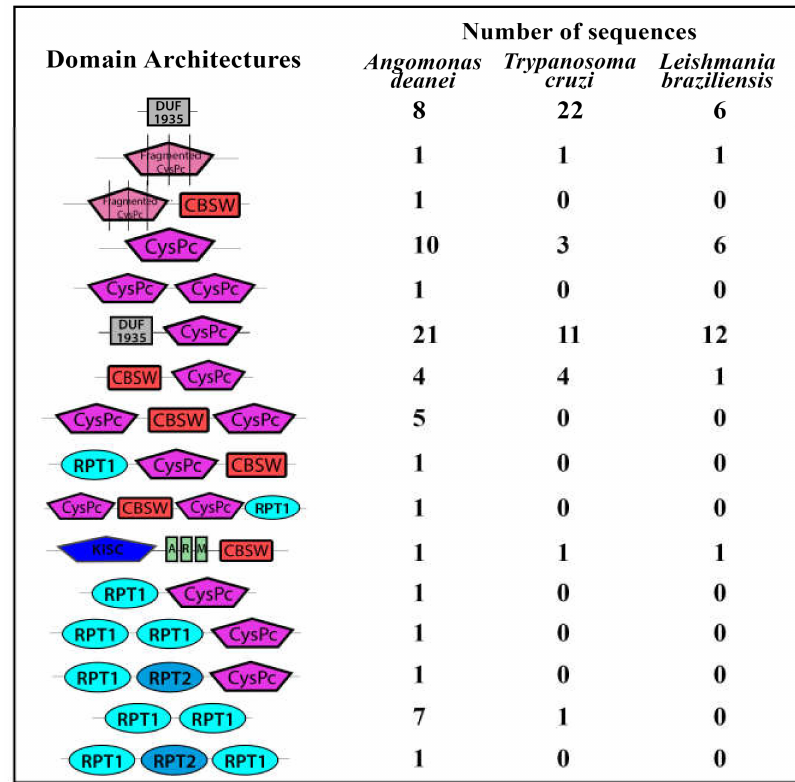
Figure 1. Schematic representation of the domain architectures from calpain sequences found in the Angomonas deanei genome. The calpain sequences were retrieved from two different assemblies from the Angomonas deanei genome (Genbank ID 14191) and were locally analyzed by the Simple Modular Architecture Research Tool (SMART) for the domain’s presence in InterPro and Pfam databases. The number of calpain sequences from Trypanoma cruzi [10] and Leishmania braziliensis [11] presenting the same domain architectures is illustrated for comparison. Sequences annotated as “calpain-like proteins” that have less than 100 amino acids or that do not have any calpain associated domain were not included. DUF1935—conserved N-terminal calpain-related domain from trypanosomatids,